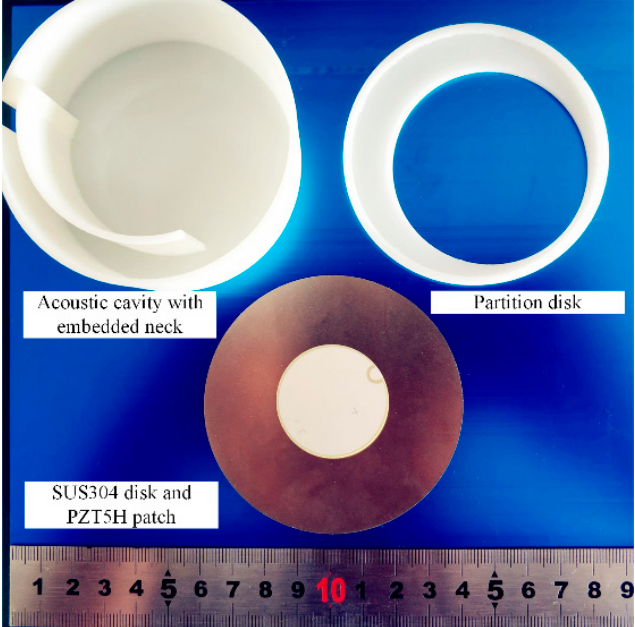
Figure 13. Photograph of the components of the tapered AEH device [47].